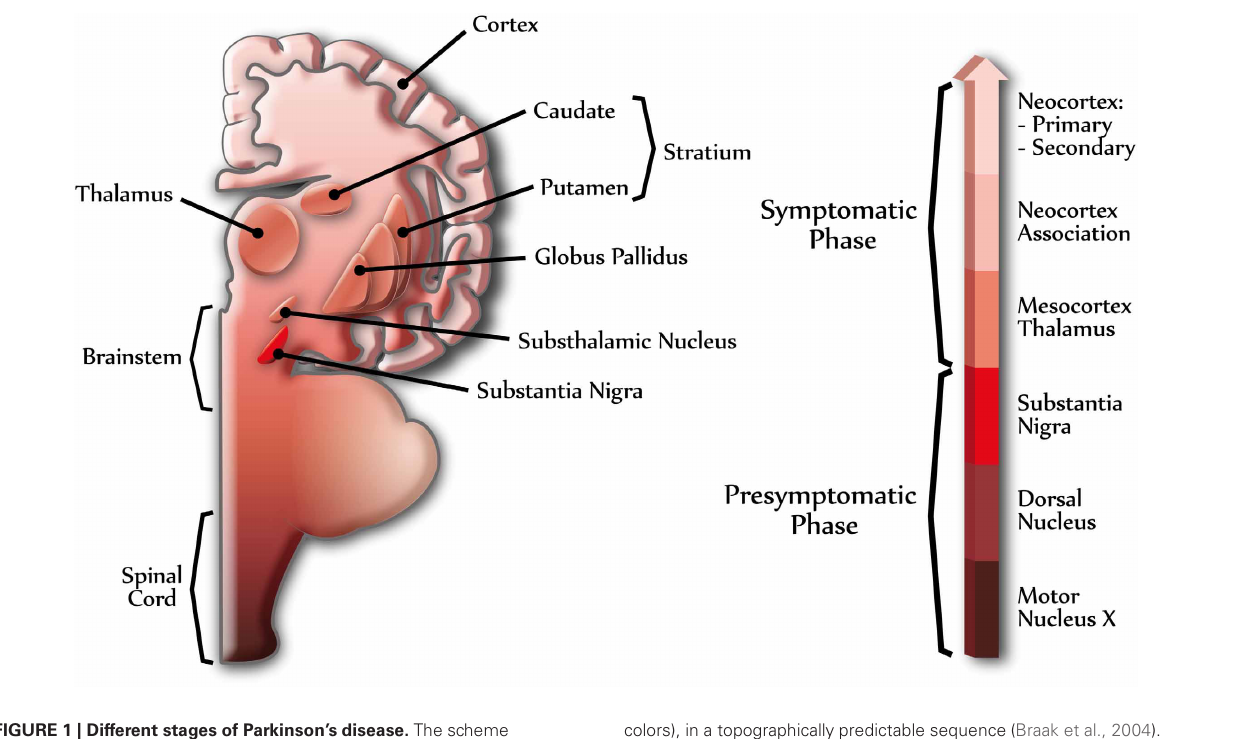
colors), in a topographically predictable sequence (Braak et al., 2004). The right arrow shows the progression of PD, indicating some of the brain regions related to presymptomatic and symptomatic phases. Dark colors indicate early stages of PD and light colors indicate late stages of